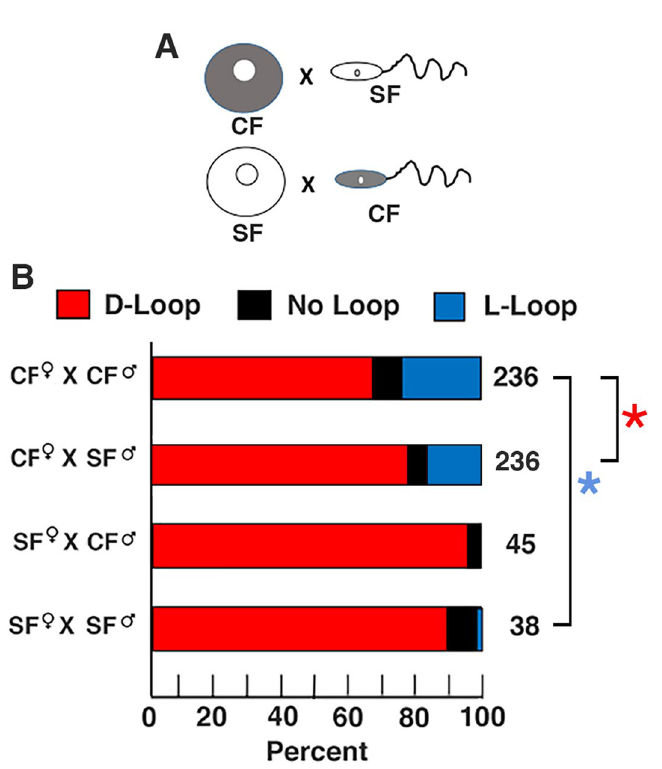
Figure 5. Role of lefty2 downregulation in Nodal/Pitx2 signaling and heart L-R asymmetry. ( A – D , F – H ) In situ hybridization showing lft1 ( A – D ) and lft2 ( F – H ) expression in surface fish ( A , B , F ) and cavefish ( C , D , G , H ) at 50% epiboly. ( A , C ) Dorsal views. ( B , D , F – H ) Lateral views. Arrows in ( A , C ) indicate the shield region and in ( F – H ) indicate the germ ring. The numbers in the frames indicate embryos with the indicated expression pattern compared to the total number of in situ hybridized embryos. Scale bar in B: 150 µm; magnification is the same in all frames. ( E ) Bar graphs showing relative fold changes in lft1 , lft2 , and ndr1 mRNA in cavefish compared to surface fish gastrulae determined by qPCR at the 50% epiboly stage. Black bars: surface fish. Yellow bars: cavefish. Error bars: SEM. Number of replicates shown at the bottom of the columns. Asterisk: p < 0.01. ( I ) Effects of the Nodal inhibitors SB-431542 and SB-505124 on heart L-R asymmetry in cavefish. Bar graphs showing the proportion of D-looped, non-looped, and L-looped hearts in cavefish controls and 1 µM and 5 µM SB431542 or SB-505124 treated larvae stained with MF-20 antibody at 3 days post-fertilization (dpf). The numbers of assayed fish are shown at the right of each bar. Asterisk: Chi 2 statistic = 62.2813; p < 0.00001. ( J , K ) Effects of lft2 CRISPR-Cas9 on heart looping in surface fish at 3 dpf. ( J ) Examples of larvae ( L ) with axial defects (L1–4, top) and mutated lft2 sequences (bottom, underlined in green) in 4 injected surface fish compared to a wild type surface fish control (WT) from the same clutch. Red arrows: sgRNA target. Scale bar is 100 µm; magnification is the same in all frames. ( K ) Bar graphs showing proportion of heart looping asymmetry in genotyped injected surface fish with (top) or without (middle) mild axial phenotypes compared to controls from the same clutch (bottom). The numbers of assayed fish are shown at the right of each bar. Asterisk: Chi 2 statistic = 6.1667; p = .187043.